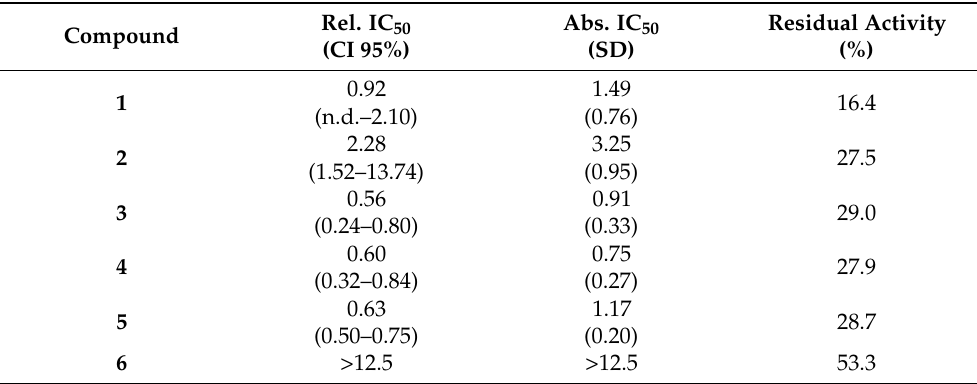
Figure 5. ( a ) Inhibition of bovine erythrocyte GPx1 enzyme activity as a function of pentathiepin concentration at 25 ◦ C, displayed as means with the corresponding 95% confidence intervals (CI 95%). ( b ) Relative activity of glutathione reductase (GR) after treatment with 25 µ M of pentathiepins 1 – 6 . ( c ) Relative activity of catalase (CAT) after treatment with 25 µ M of pentathiepins 1 – 6 . The data represent the mean and SD or CI 95% of n ≥ 3 independent experiments. Table 1. Relative (Rel.) and absolute (Abs.) IC 50 values of pentathiepins 1 – 6 in µ M with corresponding CI 95%, SD, and residual bovine erythrocyte GPx1 enzyme activity at the highest tested concentration of 12.5 µ M of n ≥ 3 independent experiments.